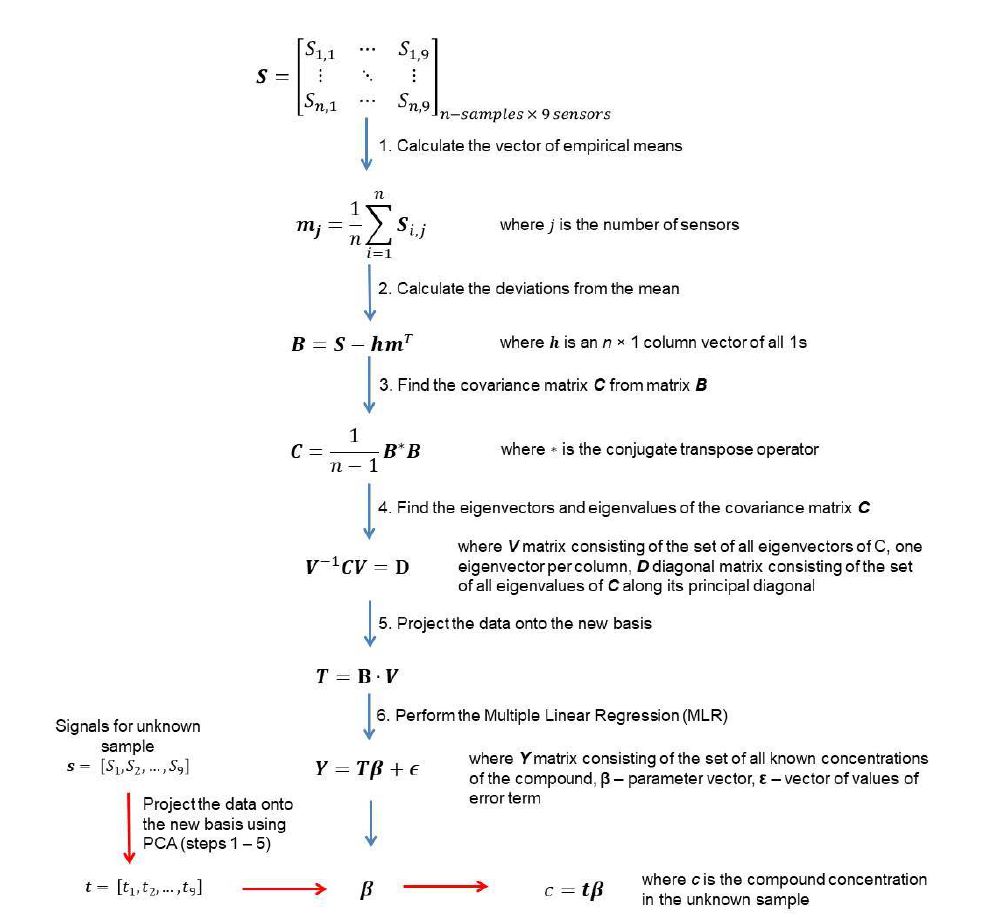
Figure 3. The PCR